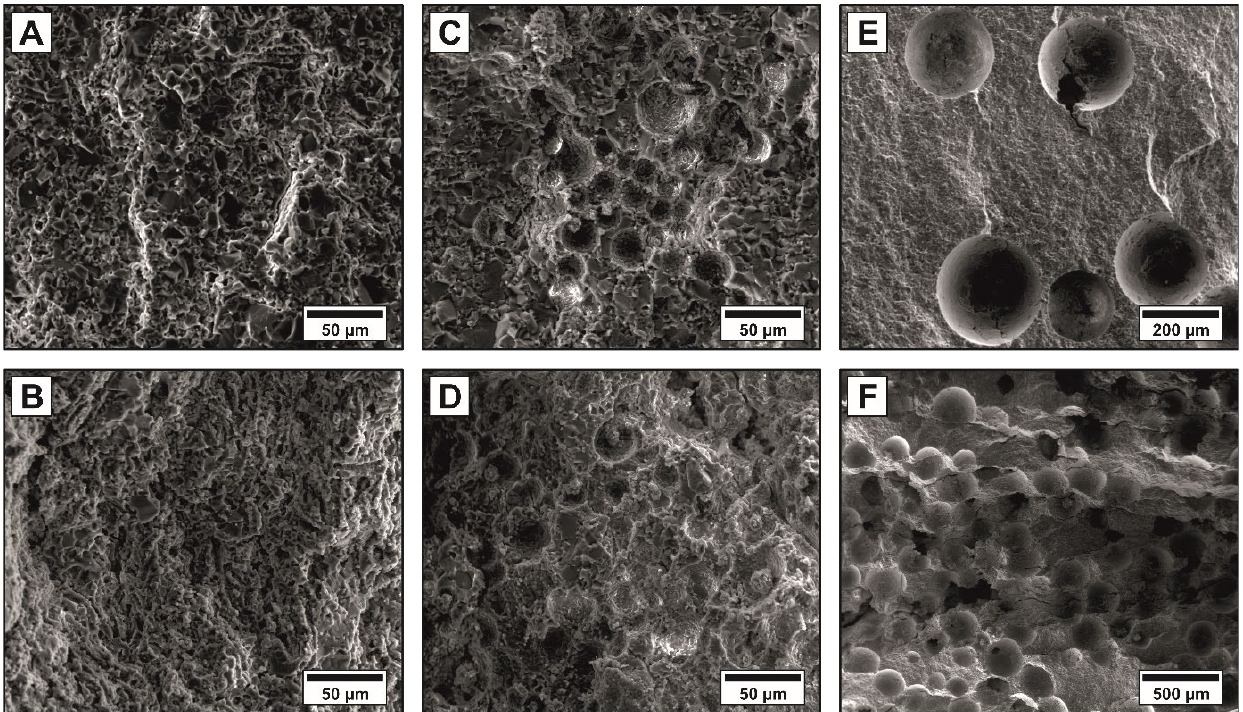
Figure 3. Microstructure of the monomodal samples: SEM micrographs of the typical fracture surfaces of sintered Al 2 O 3 ceramics containing monomodal distributions of pyrolyzed cellulose fibers ( A , B ), 30 µm phenolic resin spheres ( C , D ) and 300 µm phenolic resin spheres ( E , F ).